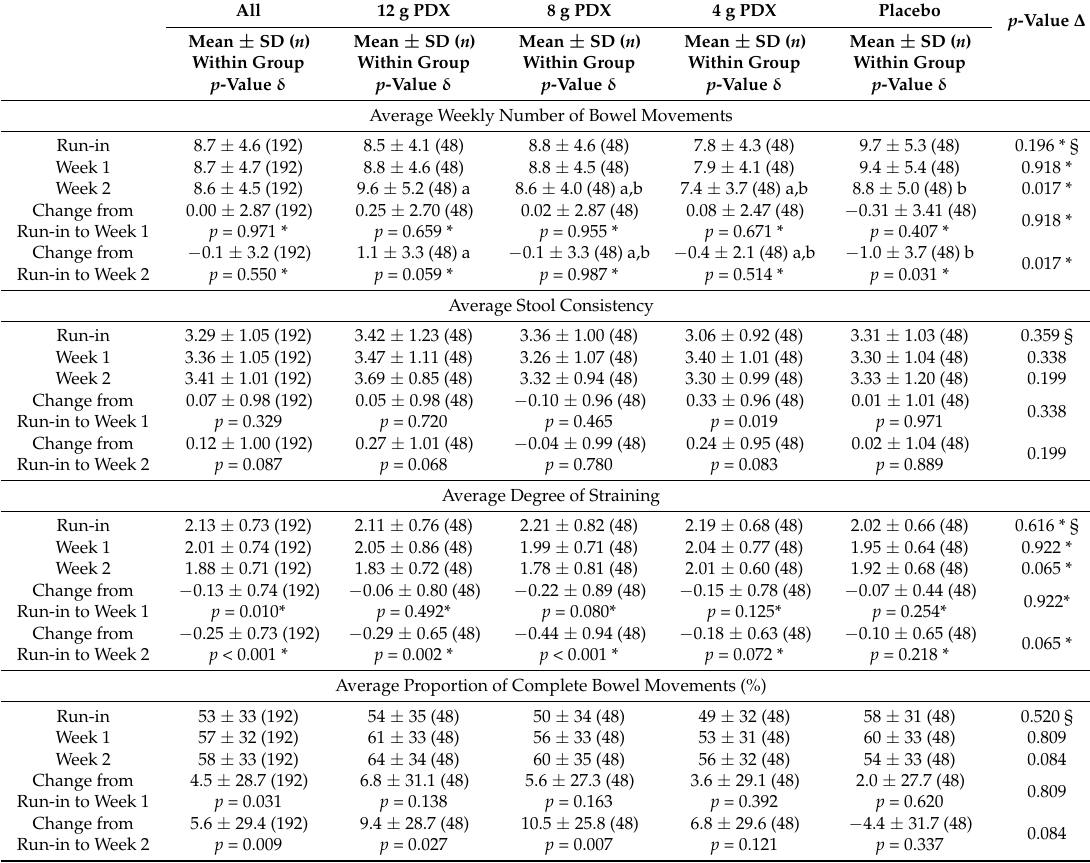
Table 7. Bowel habits for baseline (run-in), week 1, and week 2 for participants in the intention-to-treat population ( n = 192).